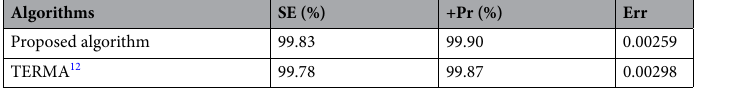
Algorithms SE (%) +Pr (%)